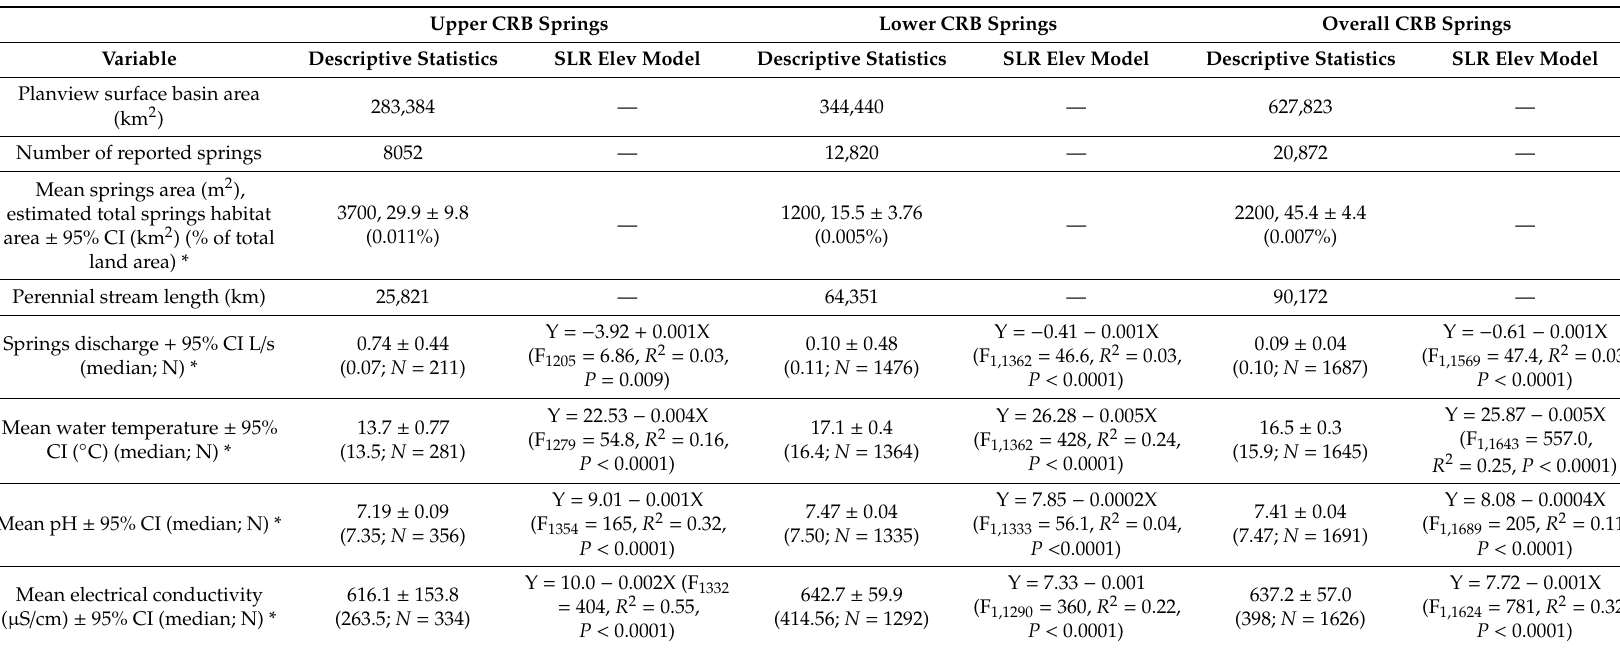
Table 1. Average geographic, physical, and geochemical characteristics of Colorado River Basin springs, by sub-basin. Simple linear regression equations (SLR; with F statistics) are provided for springs discharge, and water temperature and geochemistry variables across elevation (Elev; m). Asterisks (*) indicate statistical significance ( P ≤